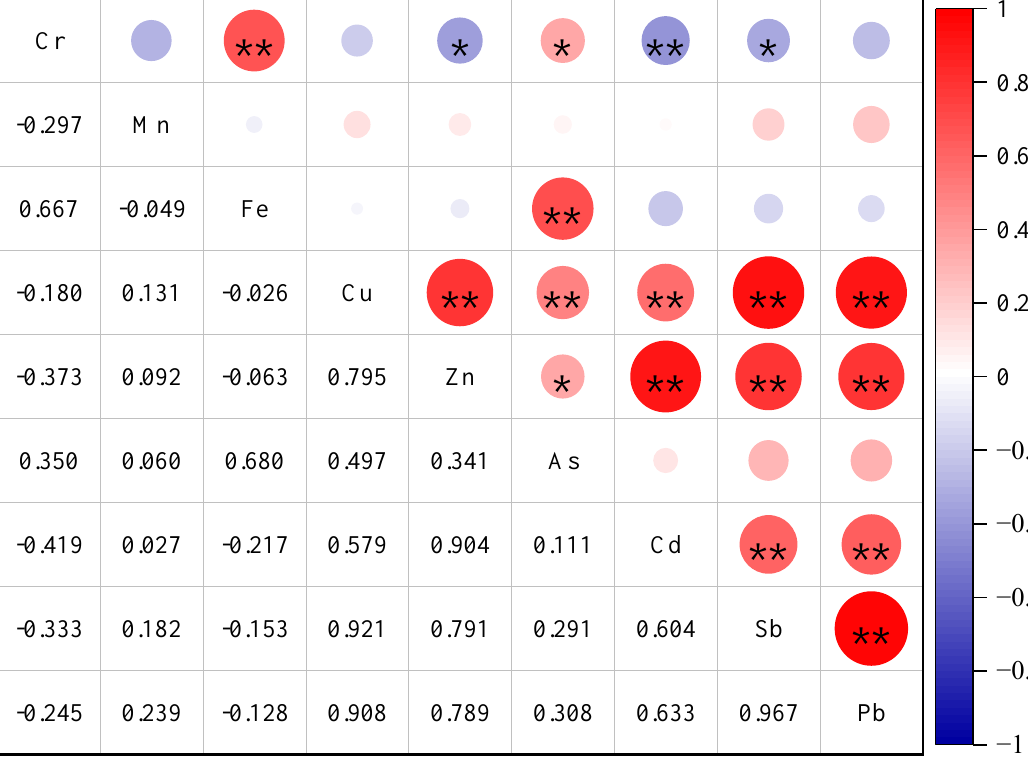
Table 3. Principal component analysis results of heavy metals ( n = 40).